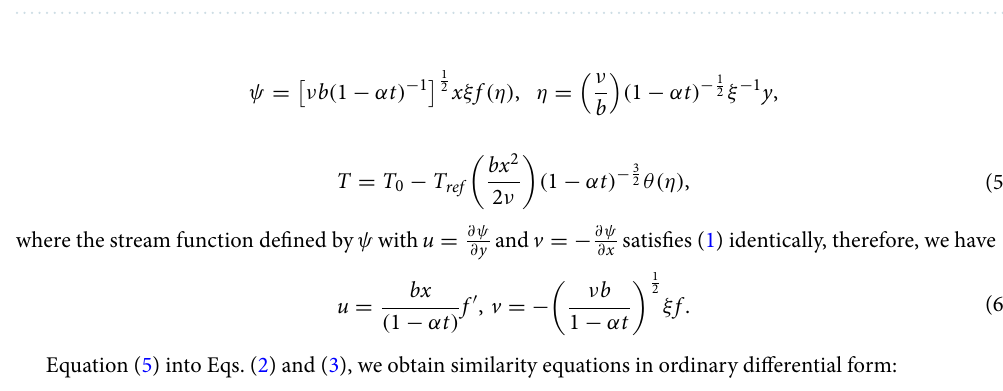
Table 2. Thermo-physical properties of the base fluid and nanoparticles 53,54